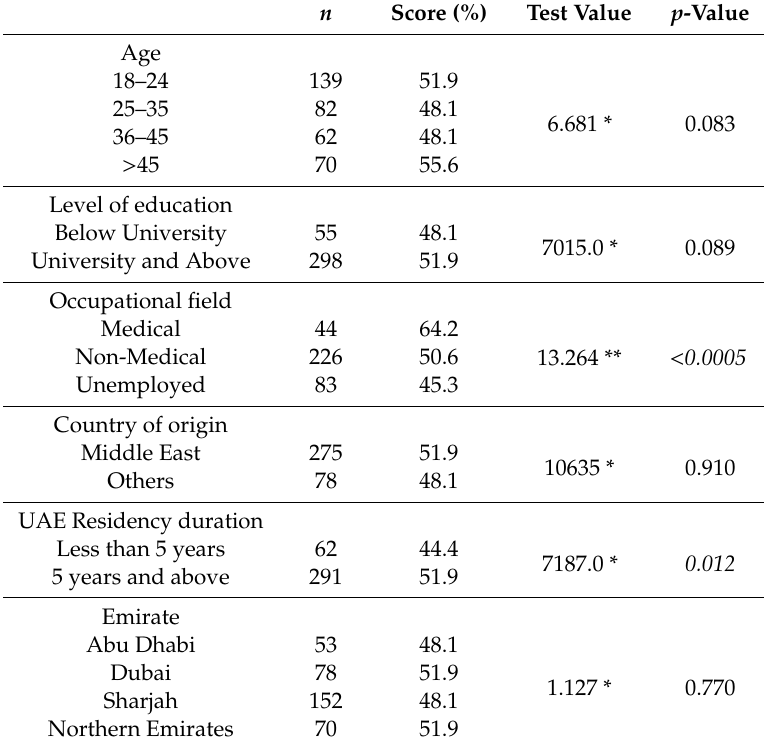
Table 1. Cancer-related Knowledge Score by Demographic characteristics of study